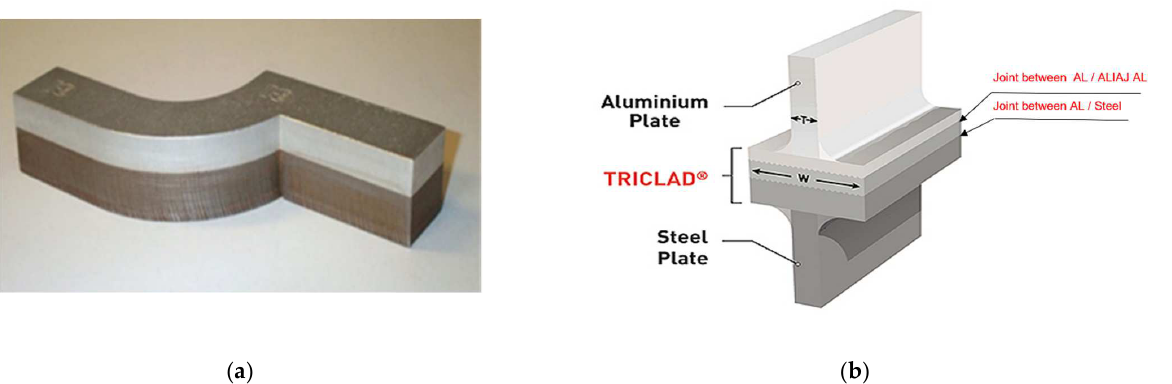
Figure 6. TRICLAD joint used in the naval sector; ( a ) TRICLAD strips; ( b ) TRICLAD composition.